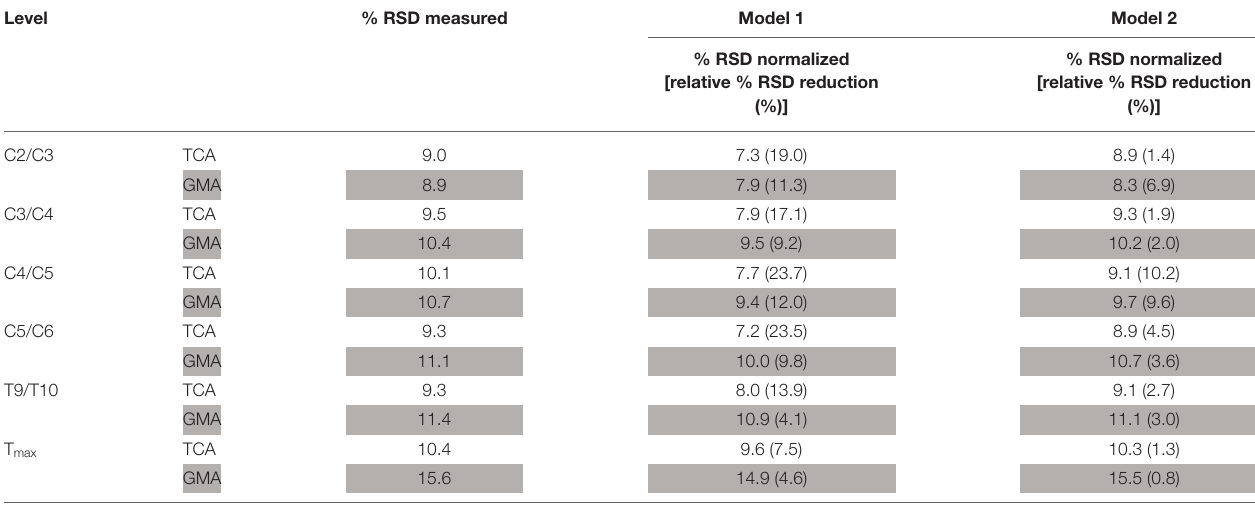
TABLE 5 | Performance of normalization by Model 1 and Model 2 for total cross-sectional cord areas (TCA) and gray matter areas (GMA) at all other cord levels.